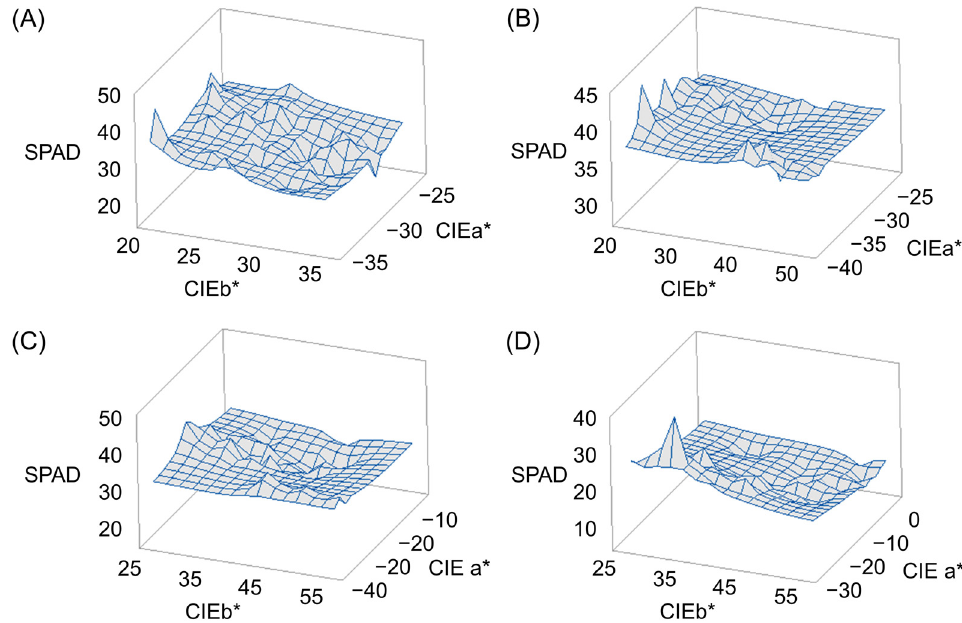
Figure 2. Response surface methodology (RSM) analysis showing relationship of CIEa* and CIEb* on chlorophyll contents. For all measurement days after heading, the lower the CIEa* and CIEb* values, the higher the chlorophyll content: ( A ) 0 days after heading date (DAH); ( B ) 15 DAH; ( C ) 30 DAH; ( D ) 45 DAH.